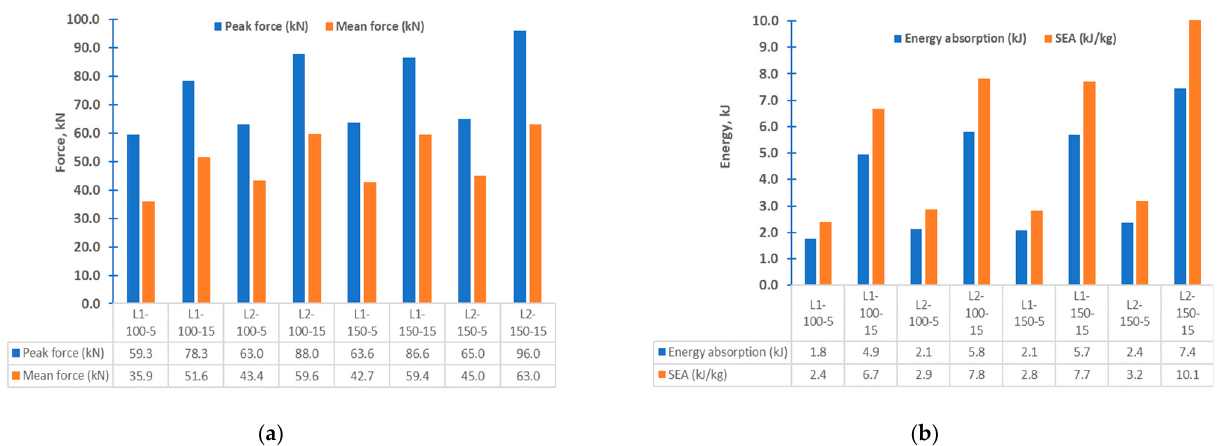
Figure 16. Summary of findings for four-point bend crushing ( a ) peak and mean force, ( b ) energy and specific energy absorption.